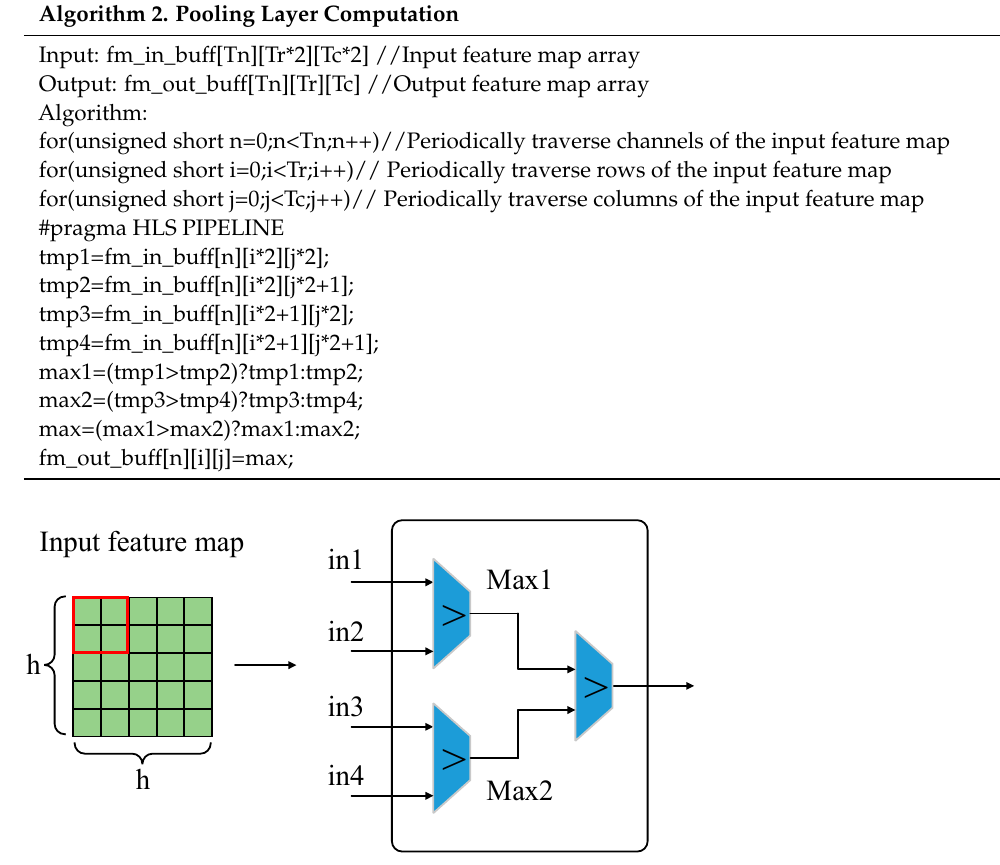
Algorithm 2. Pooling Layer Computation